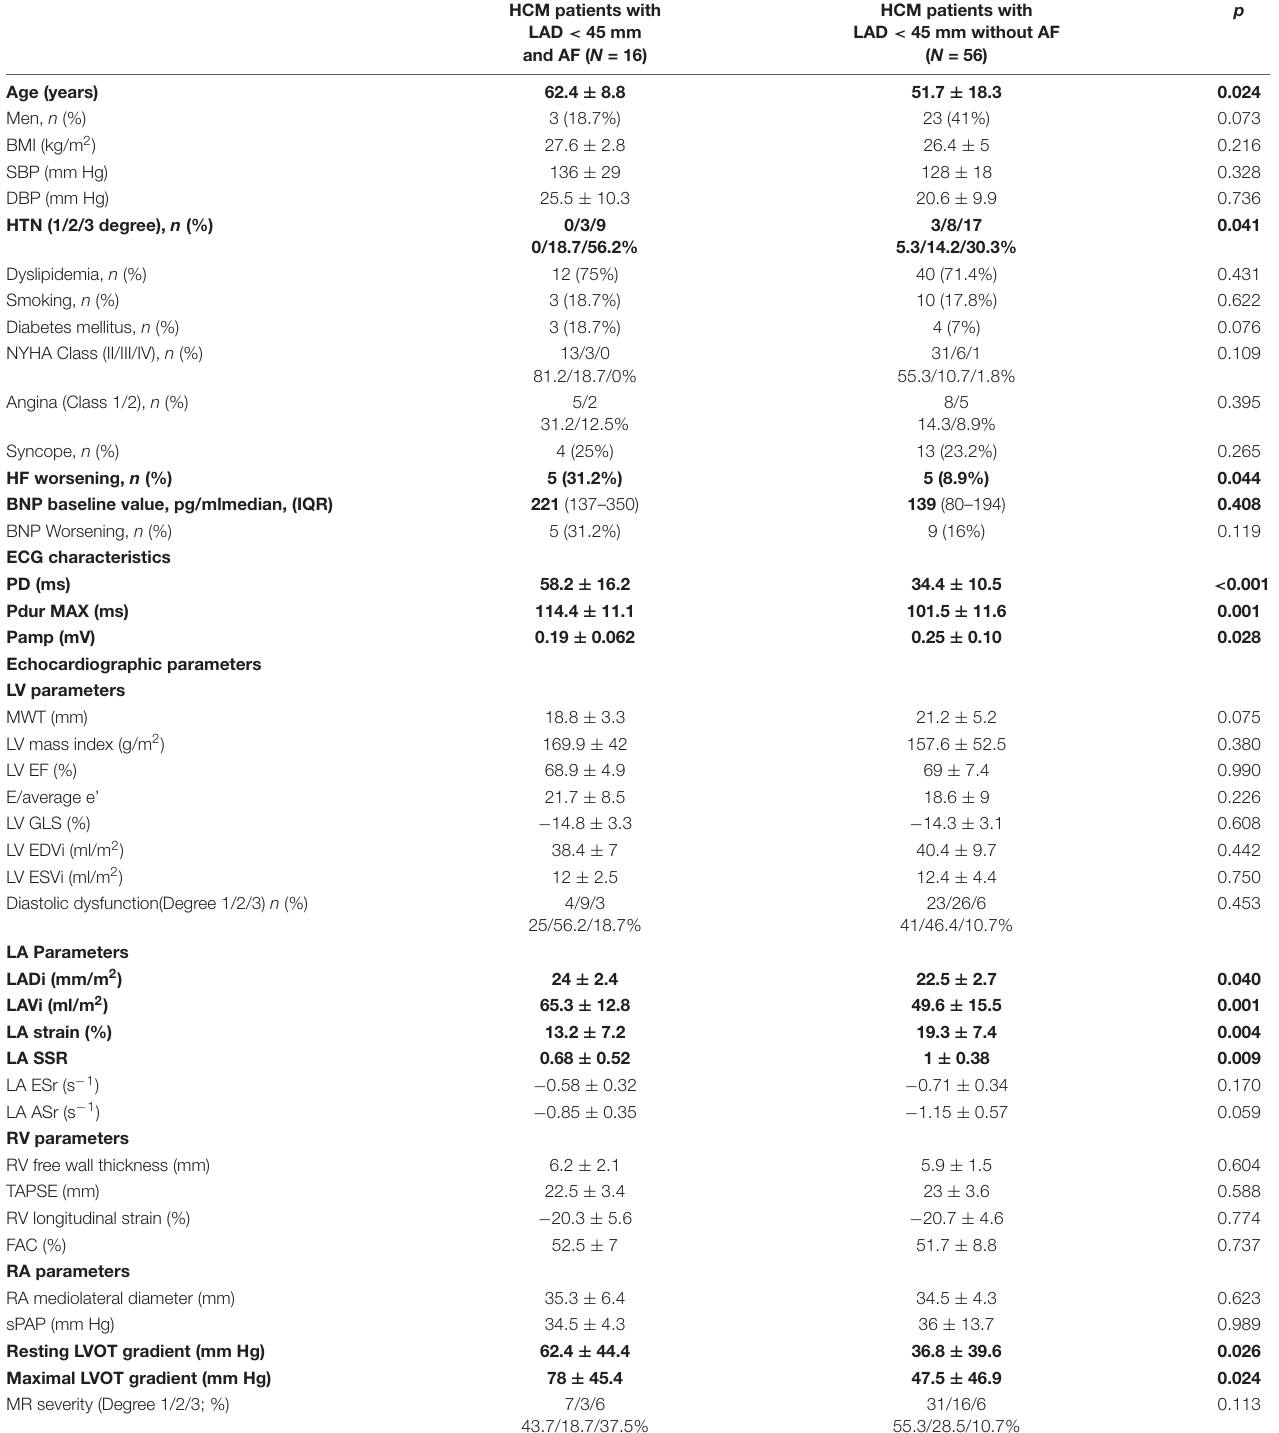
TABLE 4 | Demographic, clinical, ECG, and echocardiographic characteristics in patients with LAD < 45 mm, with and without